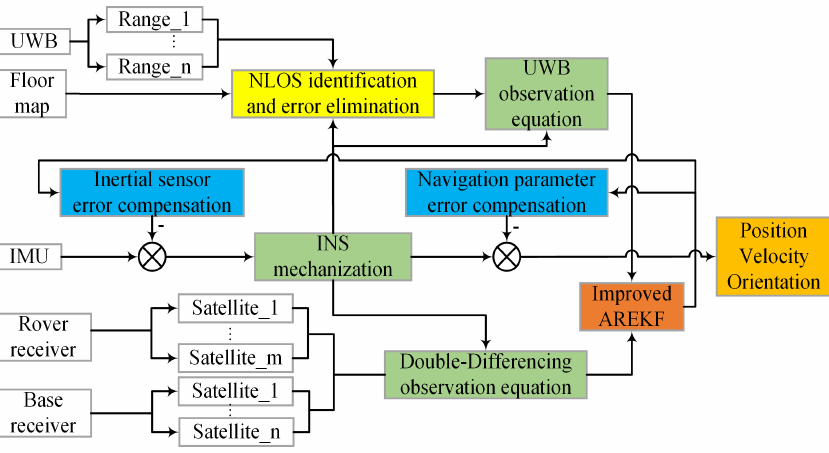
Figure 2. Algorithm